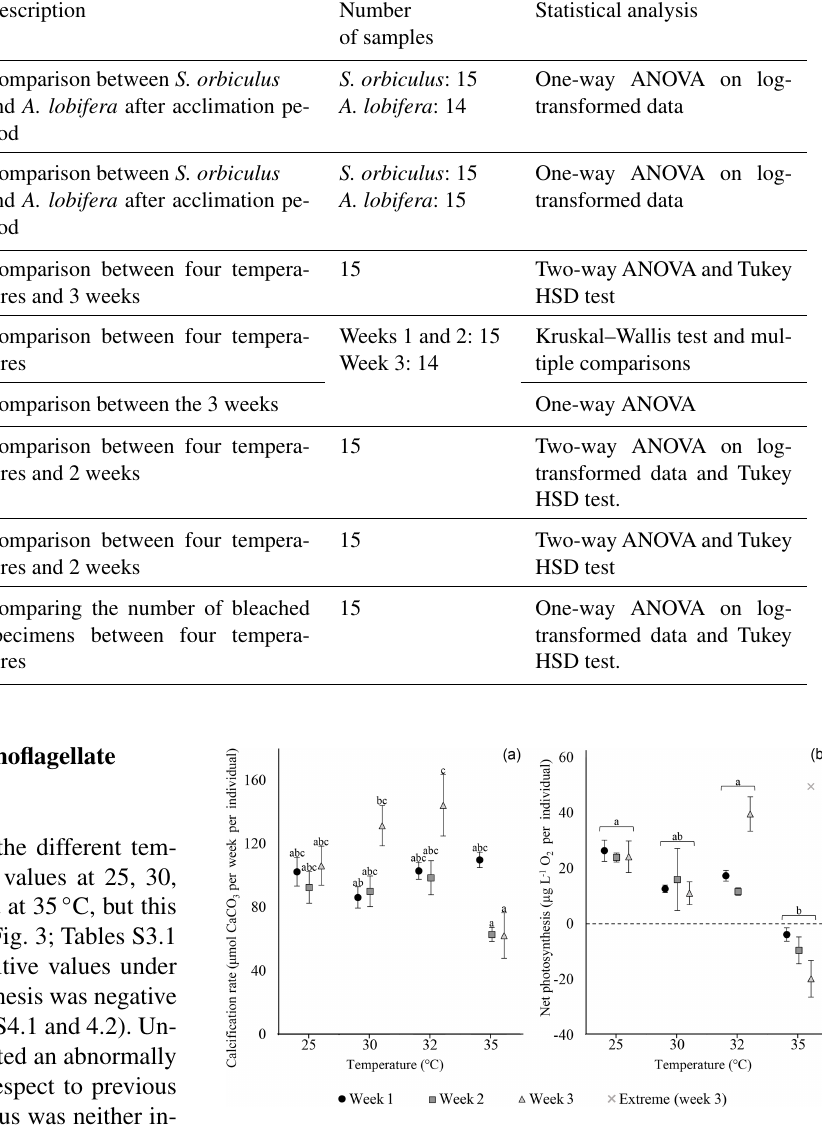
Figure 3. Calcification rates (a) and net photosynthesis (b) of S. orbiculus . Letters represent the results of the post hoc tests (Ta- bles S3.2 and S4.2). Error bars are SE. A single abnormal measure- ment, obtained at week 3, is marked as extreme and is not calculated as part of the average, error, and statistical